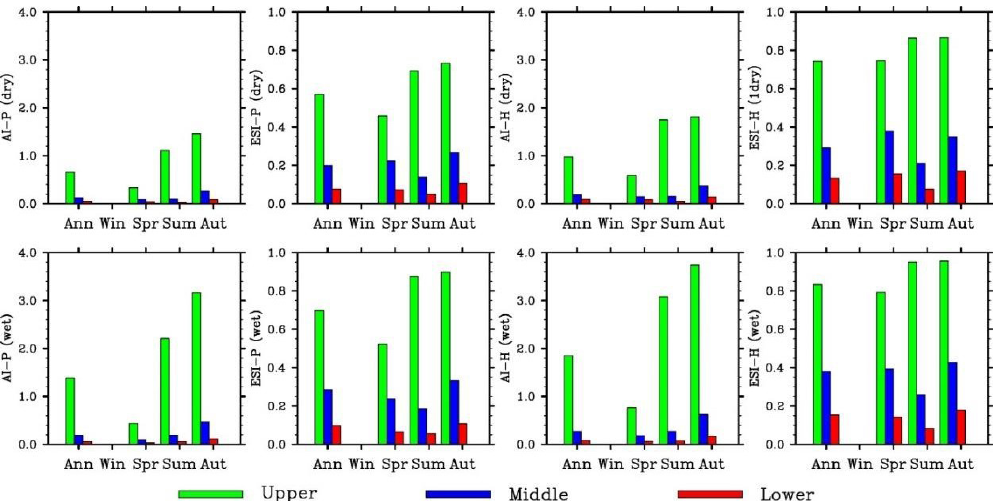
Figure 12. Seasonal variations of the simulated aridity index and evaporative stress index using the Penman–Monteith and Hamon methods (left to right) for averages over the dry years of 1982, 1990, 2001, 2008 (top) and